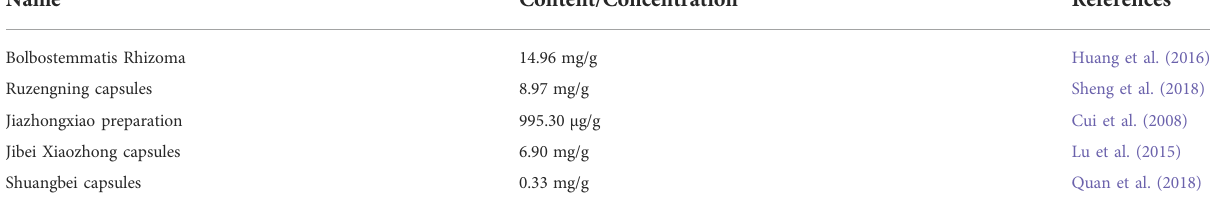
TABLE 1 The content of TBMS-1 in herbal medicine and proprietary Chinese